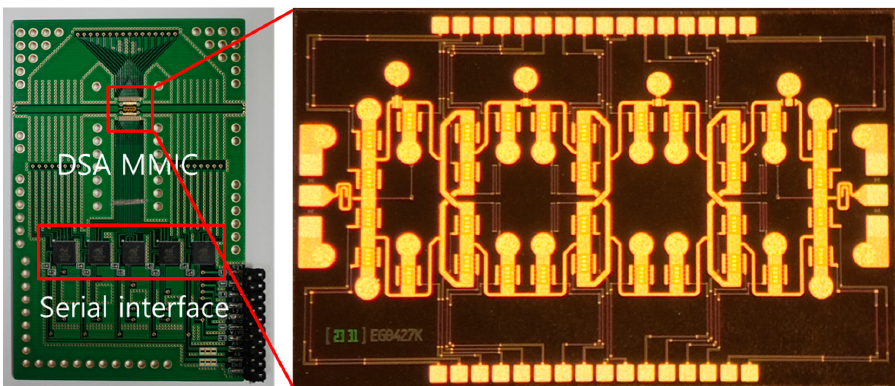
Figure 5. Microphotograph of the S/C/X-band 4-bit GaN digital step attenuator MMIC and test module.